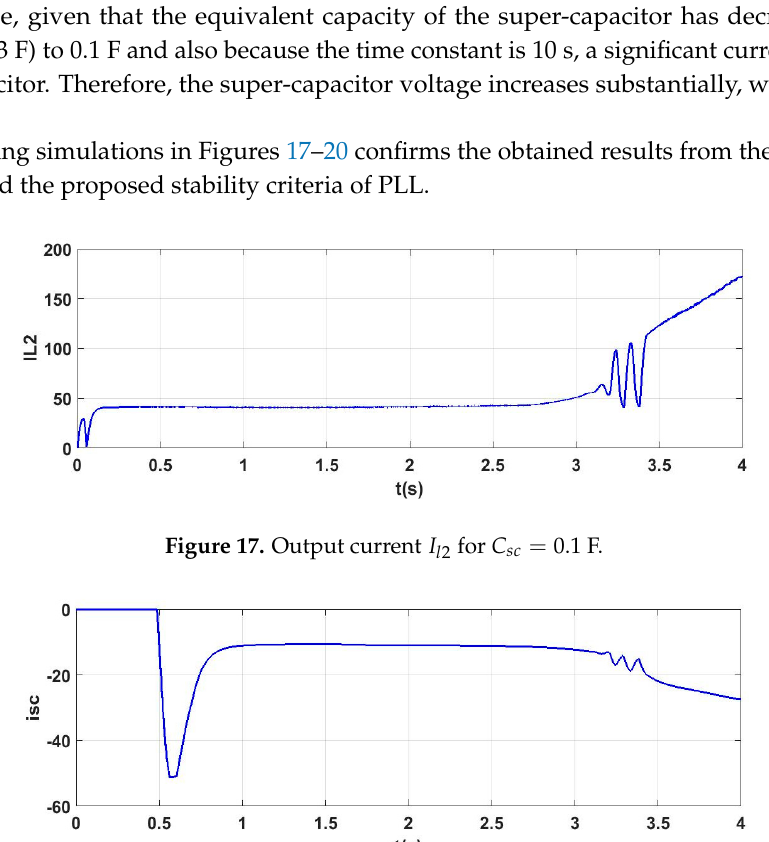
Figure 18. Super-capacitor current, affected by optimal levels for C sc = 0.1 F.